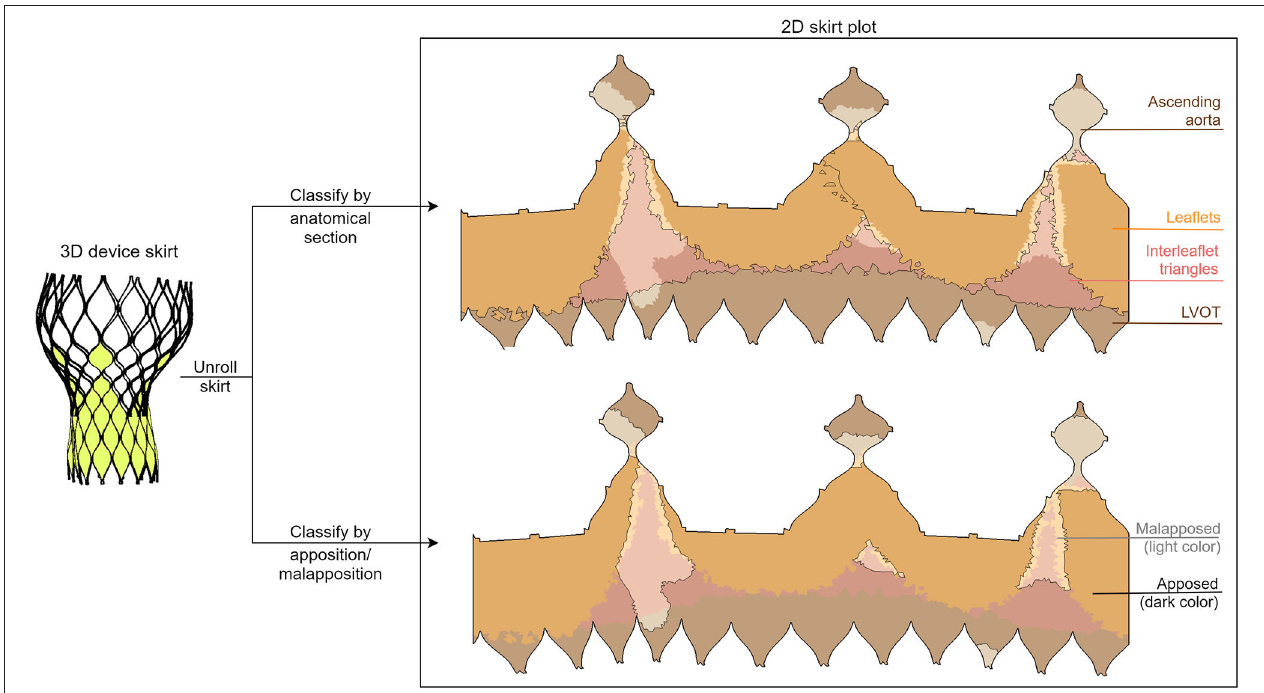
FIGURE 2 | Illustration of the division of the two-dimensional deformed device skirt into anatomical (top) and apposition/malapposition (bottom) sections. This division is evidenced both with a border line and with a color palette, as depicted in the